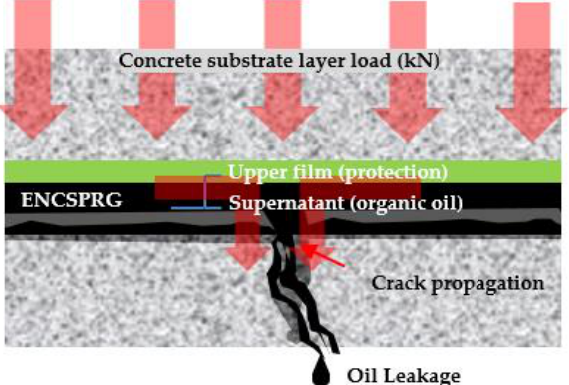
Figure 2. Illustration of oil leakage mechanism of ENC-SPRG in composite waterproofing systems.